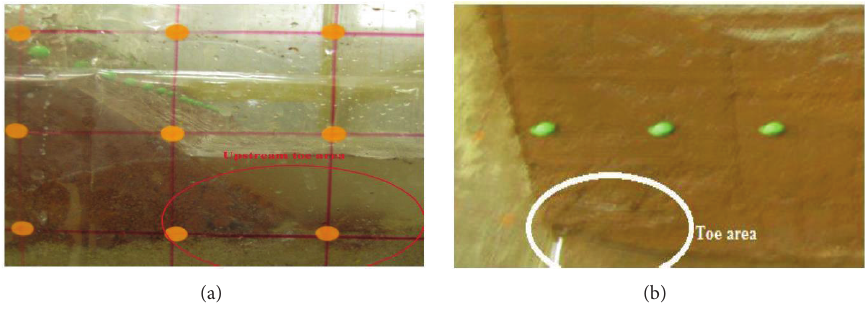
Figure 22: Damage in the third model (Model C).